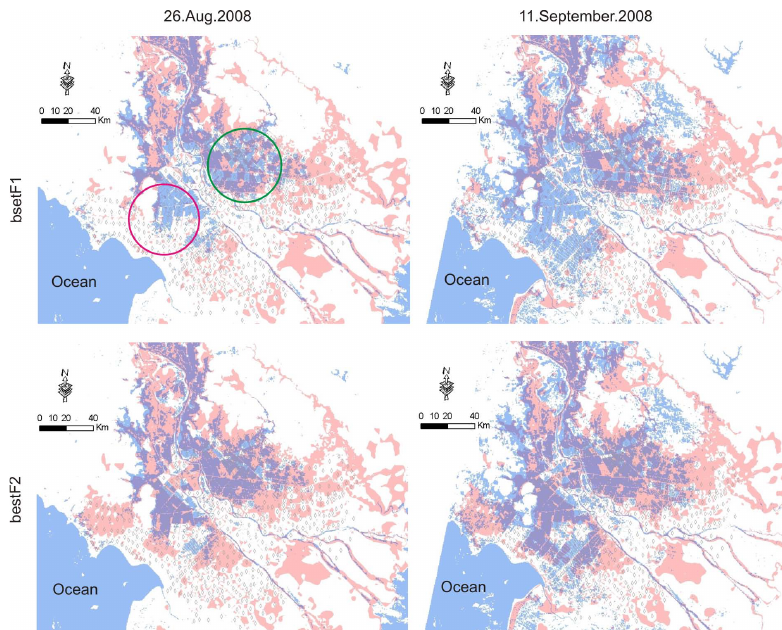
Fig. 10. Inundation areas from ENVISAT ASAR (blue) and simulated inundation areas (light red) for best solutions for F1 and F2 for two satellite overpasses during the high flood period. Areas which are both observed and simulated wet appear in purple, both simulated and observed dry appear white. The red circle indicates the Long Xuyen Quadrangle, the green circle the Plain of Reeds. The small diamonds represent the floodplain compartments for which the flood area index was calculated.